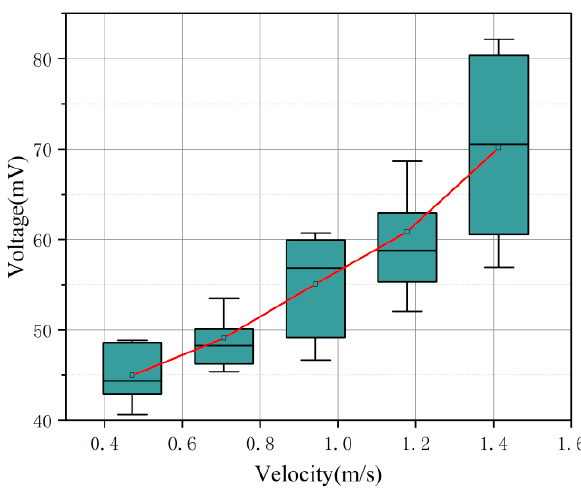
Figure 11. Variation in the output voltage with the velocity.